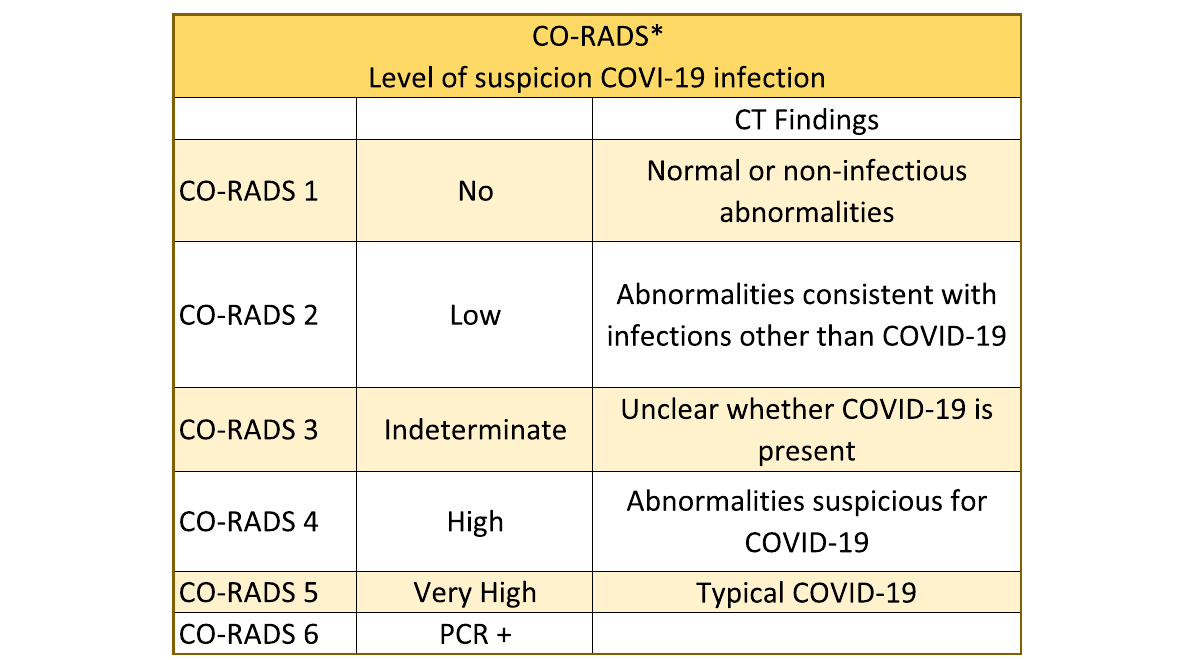
Fig. 9 CORADS classification for the level of suspicion of COVID-19 infection based on the CT